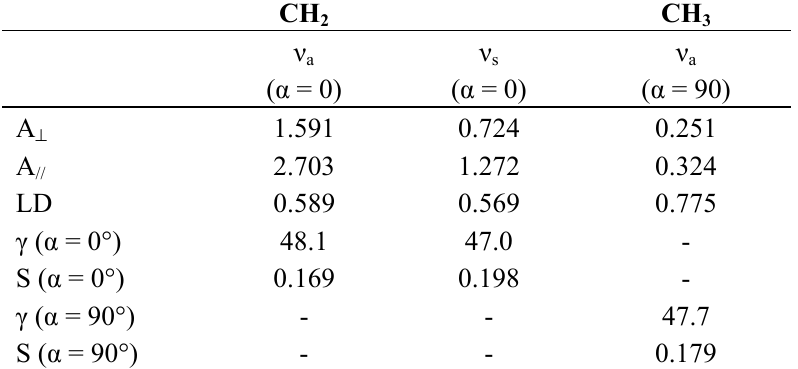
Table 1. The absorbances of CH ) stretching features at different polarization angles, the linear dichroic asymmetric ( ν a ratios (LD), orientation angle ( γ ), and order parameter (S) for the SDS molecules on the Ge